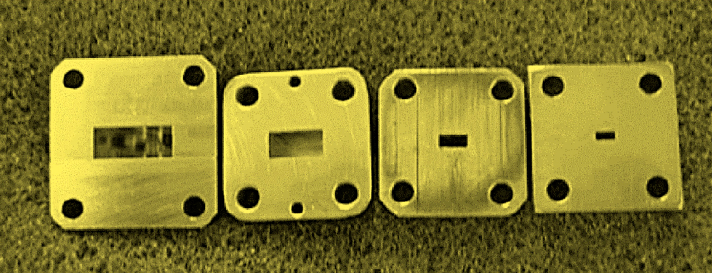
Figure 1. Front view of the flanges and apertures of standard rectangular waveguides for the (from left to right) K ‐ , Ka ‐ , V ‐ , and W ‐ bands (from [28]; copyright © 2008; reproduced with